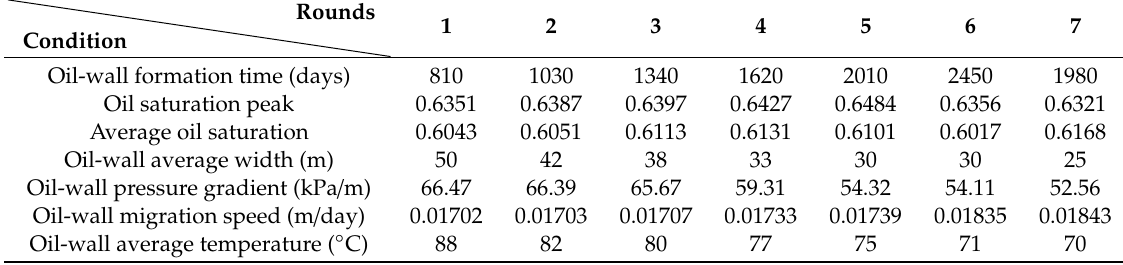
Table 3. Characteristic parameters of oil-wall under di ff erent hu ff and pu ff